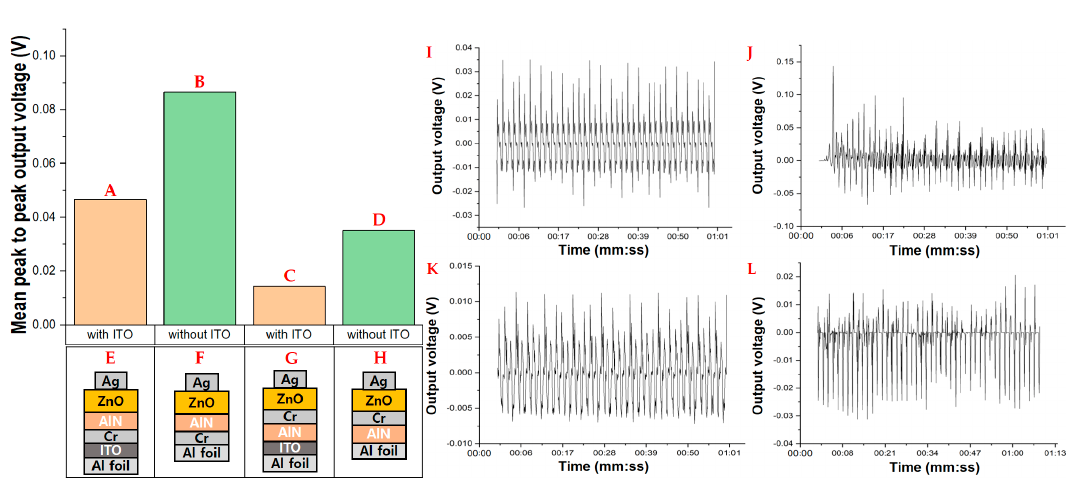
Figure 11. The output voltages of the four different devices ( A – D ) were investigated to see the effects of ITO on the device performance. The mean peak-to-peak output voltages ( top left ) and corresponding raw output voltage waveforms ( I – L ) are shown ( right ), respectively. Device structures are as follows: ( E ) Ag/ZnO/AlN/Cr/ITO/Al-foil, ( F ) Ag/ZnO/AlN/Cr/Al-foil, ( G ) Ag/ZnO/Cr/AlN/ITO/Al-foil, and ( H ) Ag/ZnO/Cr/AlN/Al-foil.